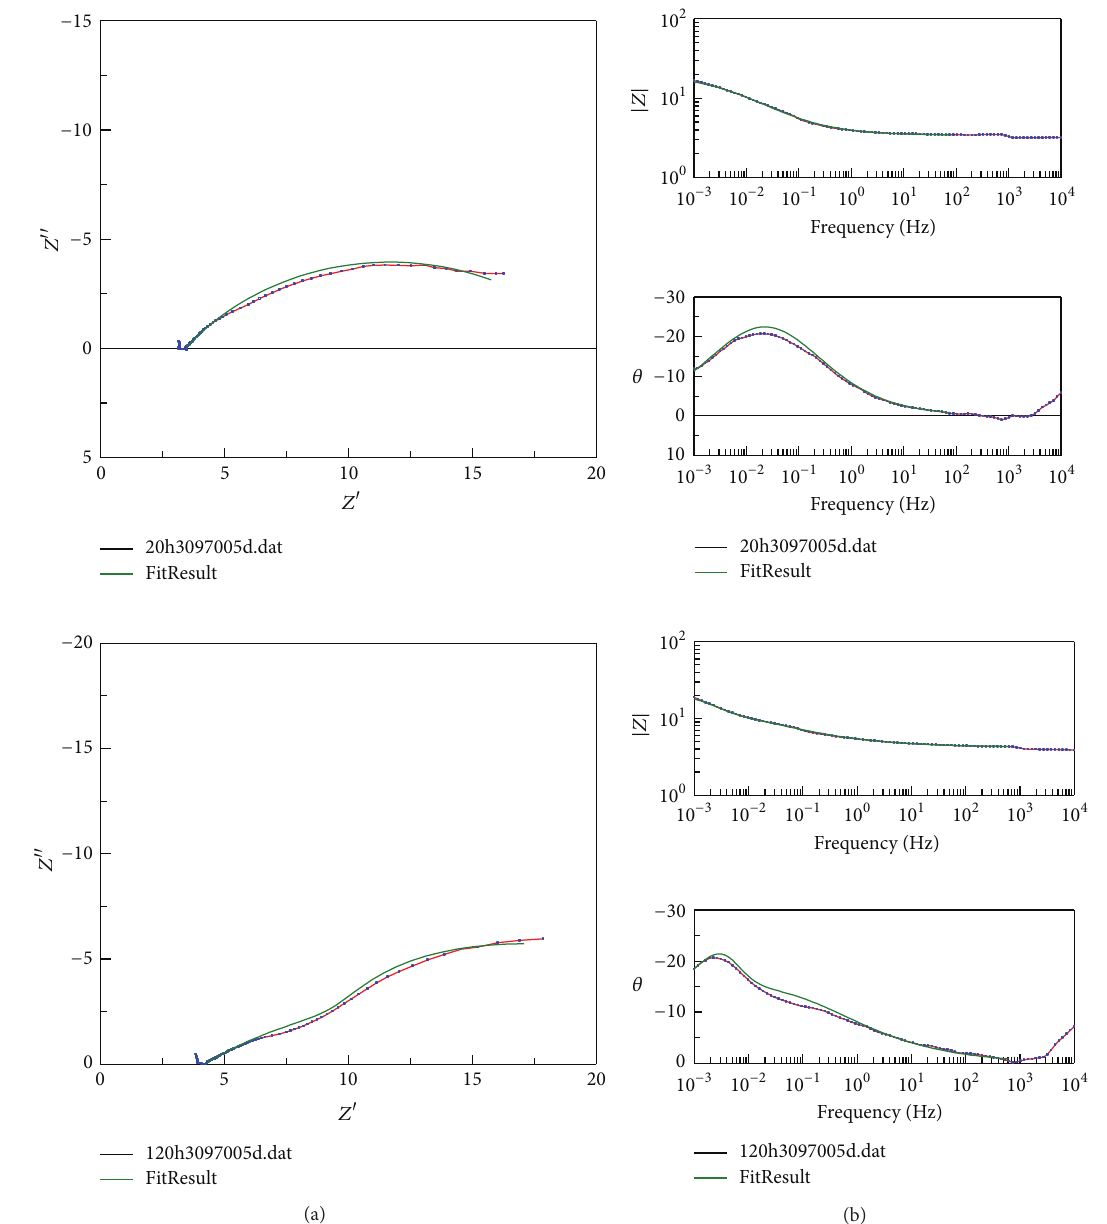
Figure 6: Experimental (red with blue circles) and fitted (green solid line) Nyquist (a) and Bode (b) plots obtained for stainless steel 309 exposed to molten salts 50 mol% V 2 O 5 -50mol% Na 2 SO 4 at 700 ∘